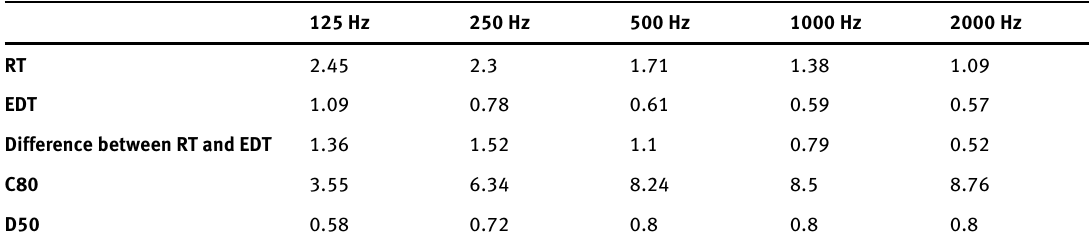
Table 1. Average values of all the receivers for the resulting values of RT, EDT, C80, D50 and difference between the average values of RT and